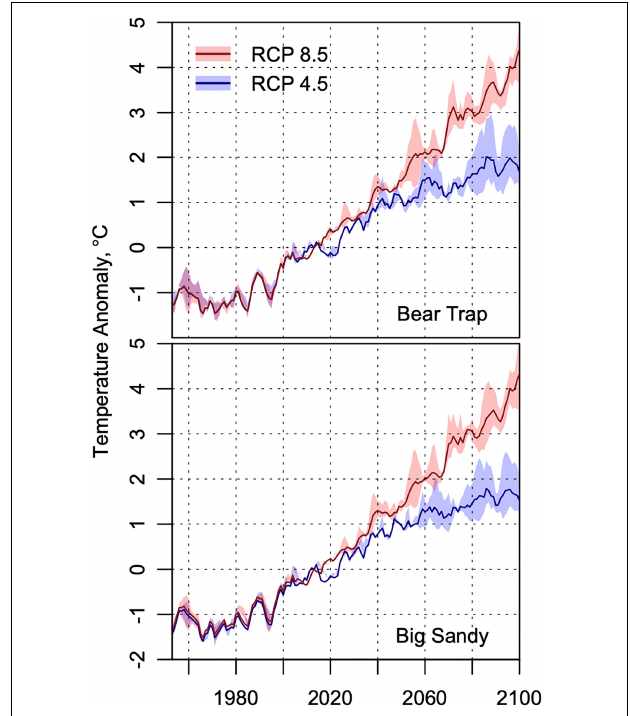
FIGURE 2 | Climate-scenario temperature anomalies based on the 2010–2013 4-year mean. Each line connects data points for annual-mean temperature anomalies calculated as a 4-year trailing mean from 1950 to 2100. Shaded areas note the range of daily minimum and maximum temperature anomalies from the two climate scenarios used to calculate the